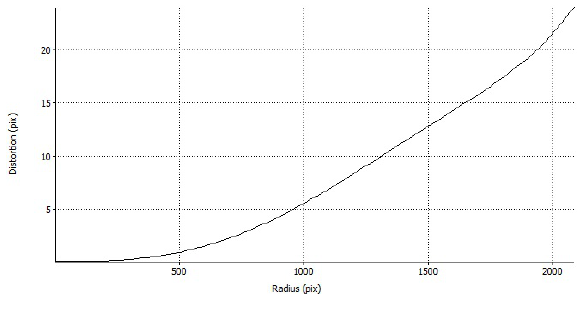
Figure 1. Radial distortion